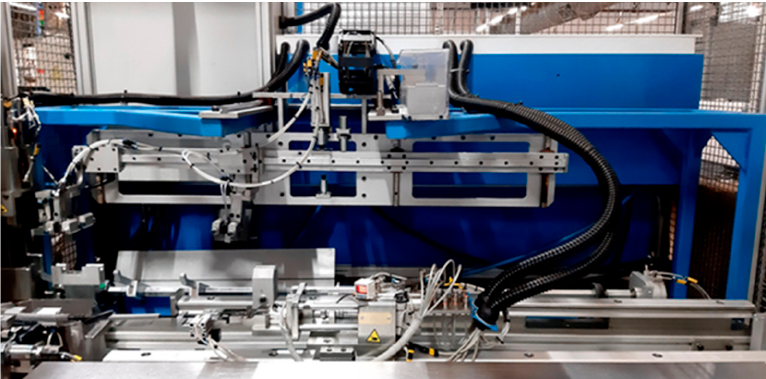
Figure 6. Robotic manipulator within the line BX726.